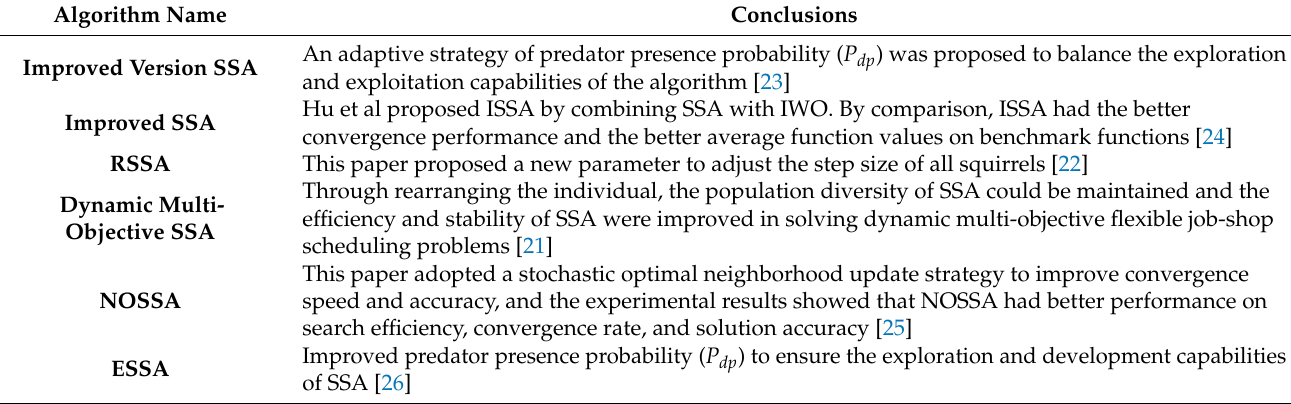
Table 1. The results of some research in recent